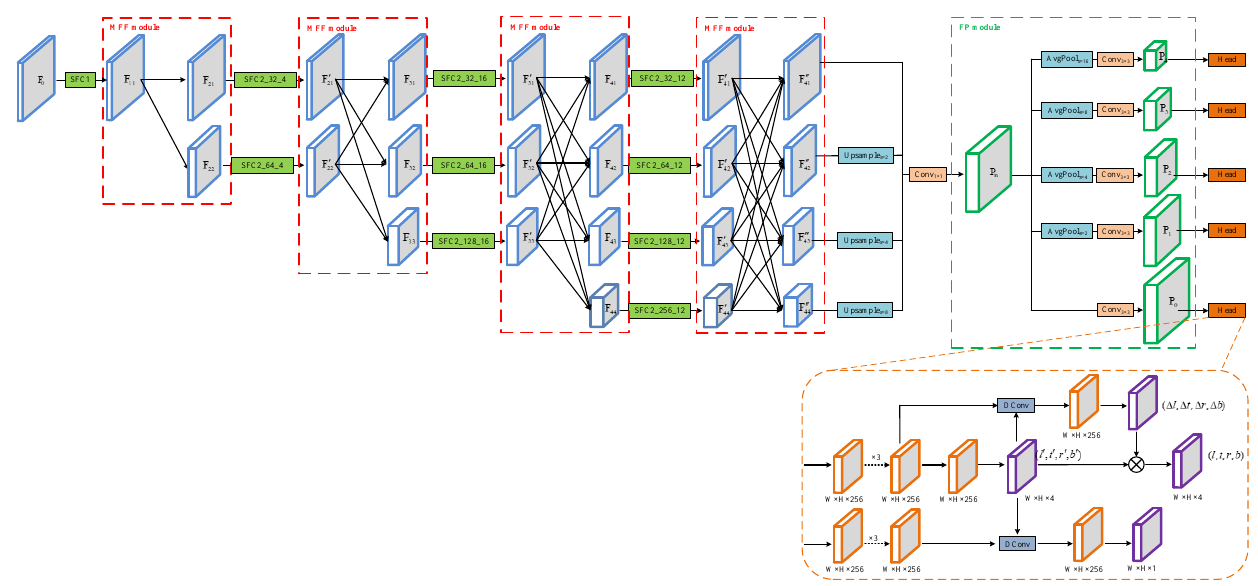
Figure 1. The overall architecture of R-FCOS. W, H denote the width and height of the feature map.